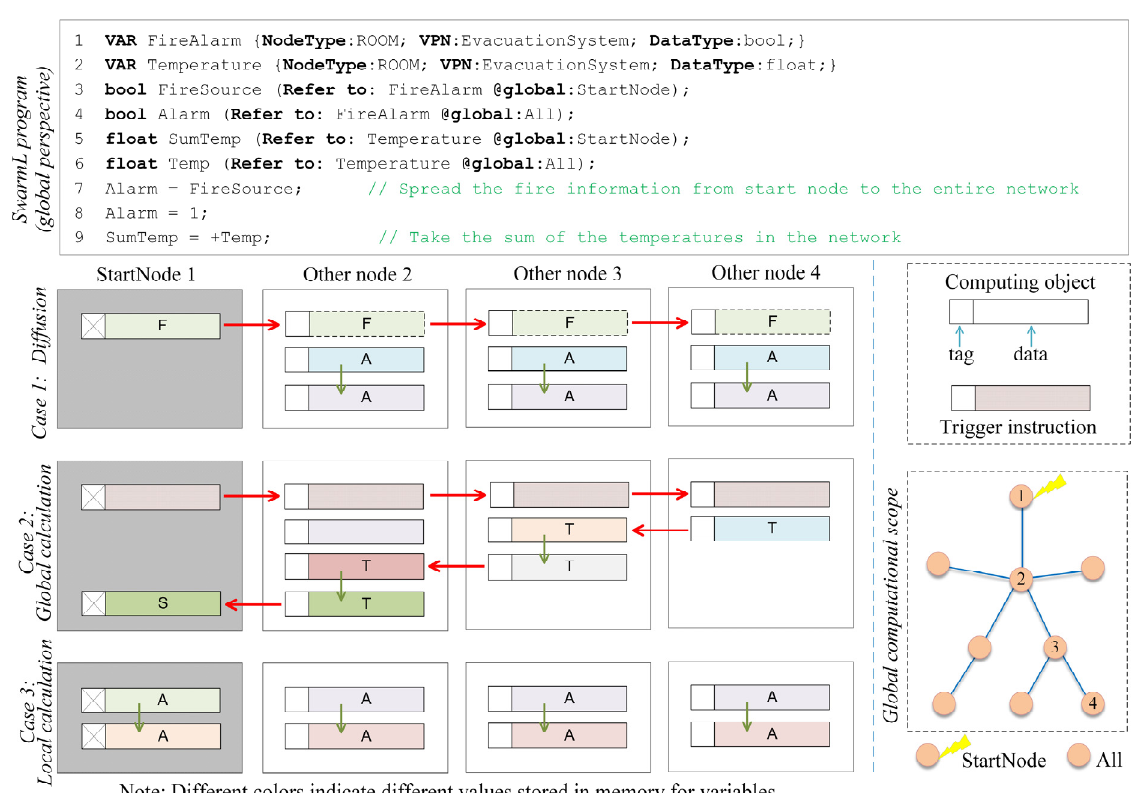
Figure 9. Task description of global synchronous diffusion and global calculation.